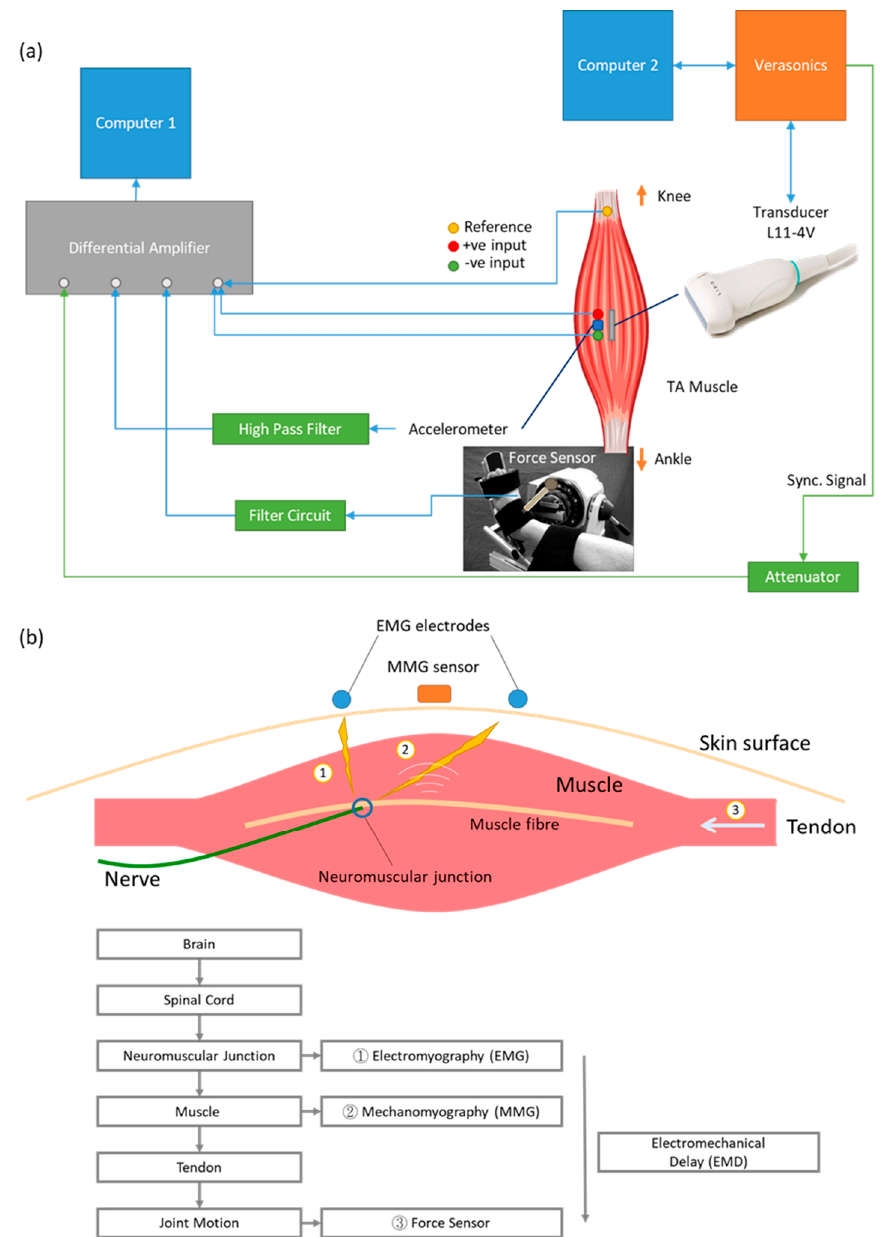
Figure 1. ( a ) Signal transmission of a voluntary muscle contraction from brain to muscle. Action potential reaches the neuromuscular junction and is detected by EMG electrodes. The action potential triggers muscle fiber motion, which is detected by MMG sensor. Muscle motion then generates joint motion through pulling the tendon. Joint motion can be detected with force sensor. The time difference between onset of EMG and onset of force is electromechanical delay. ( b ) Block diagram of setup. One computer was used to record EMG, MMG and force data from differential amplifier. Another computer was connected with the Verasonics system and controlled the transmission and recording of the ultrasound probe. A synchronization signal was generated by the Verasonics system, lengthened by an arbitrary function generator and recorded by the differential amplifier.